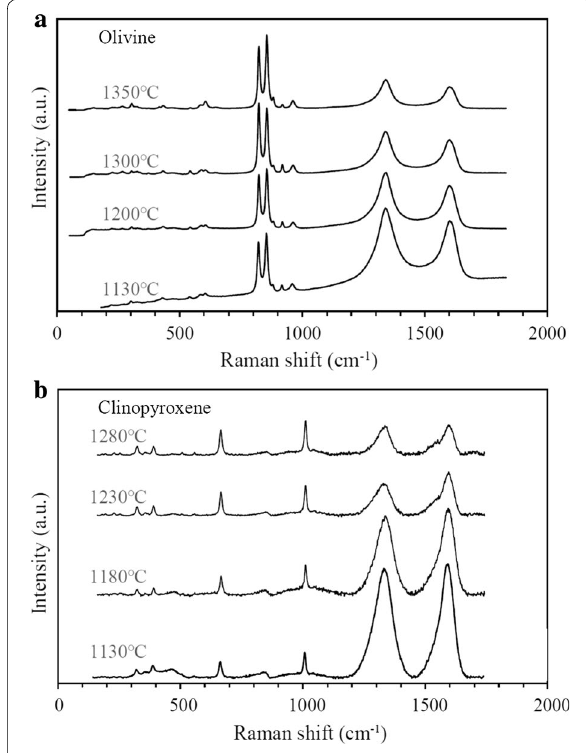
Fig. 5 Raman spectra of sintered a olivine and b clinopyroxene. Sam- ples were sintered for 2 h at different temperatures: 1130–1350 °C for olivine and 1130–1280 °C for